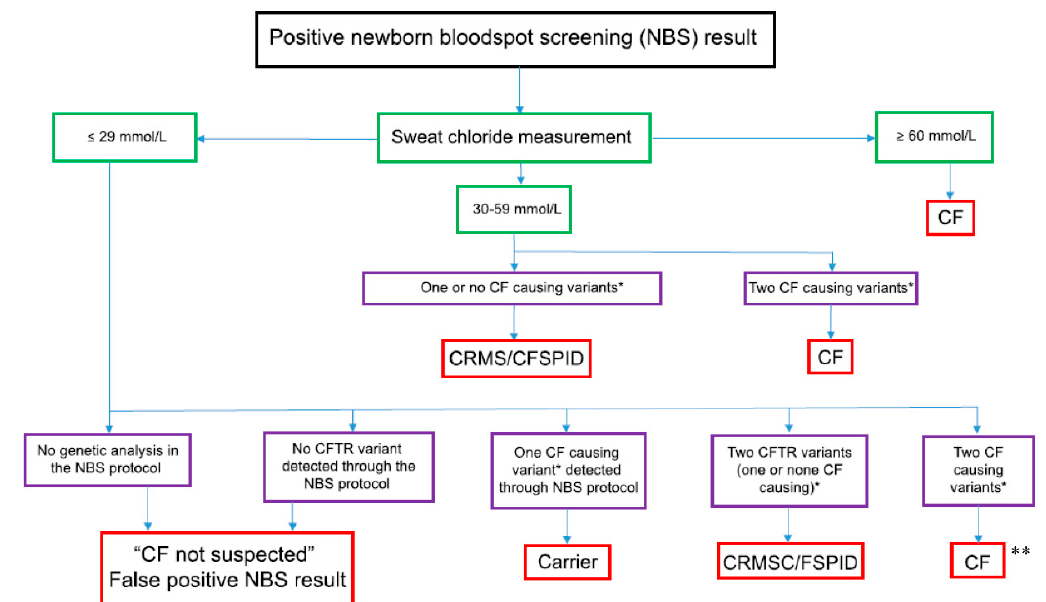
Figure 1. Adapted from reference [12] An algorithm for the designation of infants following a positive newborn bloodspot screening (NBS) result. (CF, cystic fibrosis; CFTR, CF transmembrane conductance regulator (gene); CRMS, CFTR ‐ related metabolic syndrome; CFSPID, CF screen positive, inconclusive diagnosis; CRMS/CFSPID, harmonised definition). * Characterised by the CFTR2 website. ** If two CF causing mutations are present, a repetition of a sweat test is not necessary, but the parents should be genetically tested to exclude the presence of variants in the cis form.